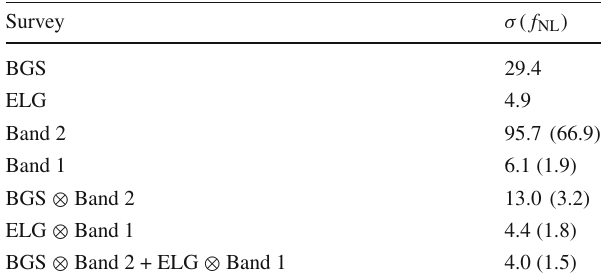
Table 2 Cumulative marginalised error σ( f NL ) for: the single-tracer surveys; the low- z and high- z multi-tracer pairs – including single- tracerinformationfromthenon-overlapvolumesasin(33);andthesum of the multi-tracer pairs. Values in parenthesis correspond to ignoring foregrounds, i.e., with k fg = 0